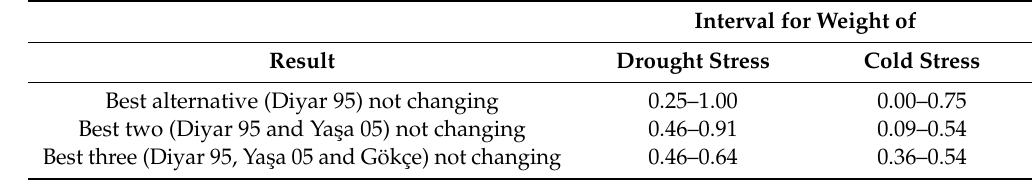
Table 15. Weight limits for best three alternatives.